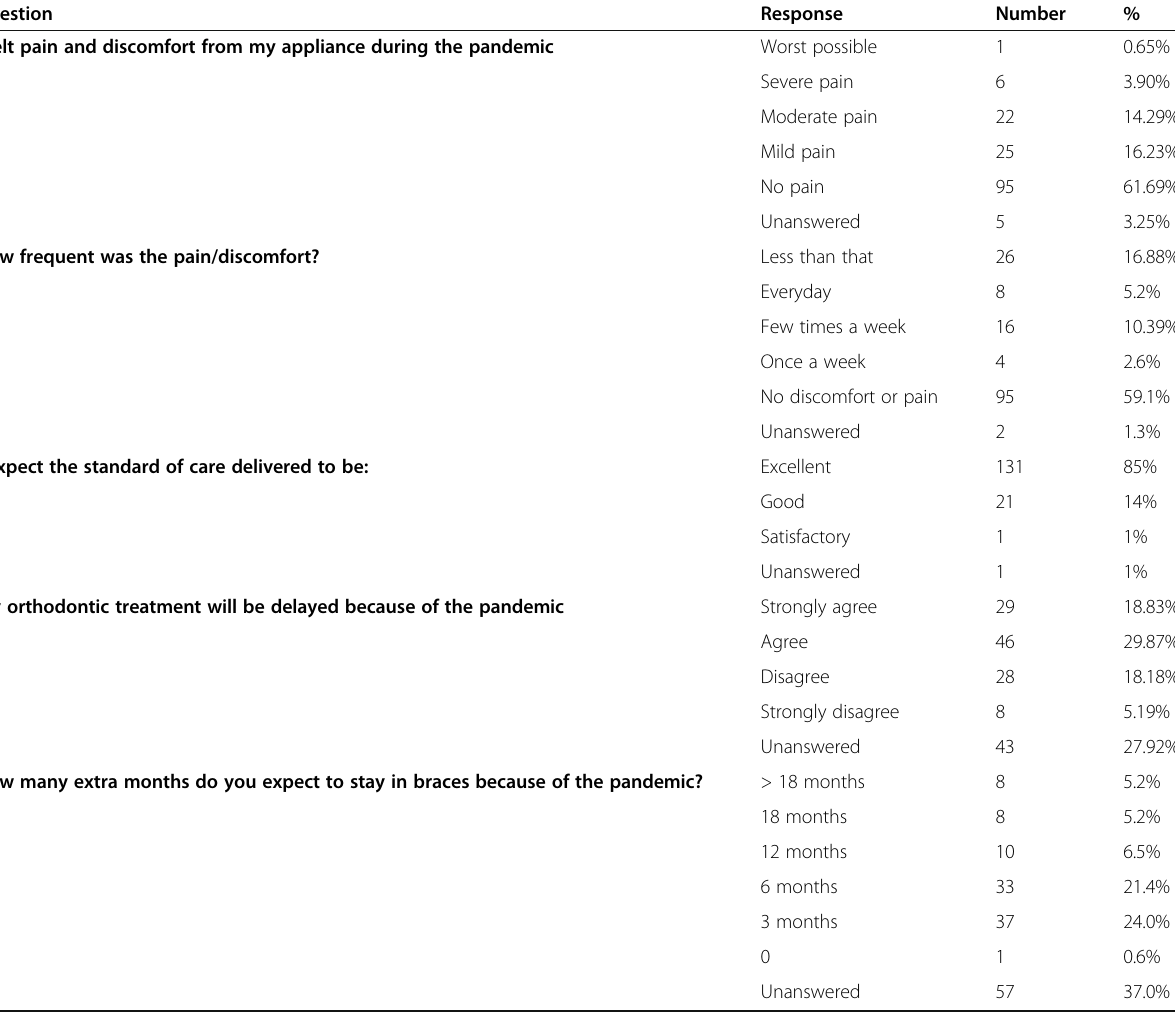
Table 2 Section 2: Psychological aspects that are relevant to clinical orthodontics during the